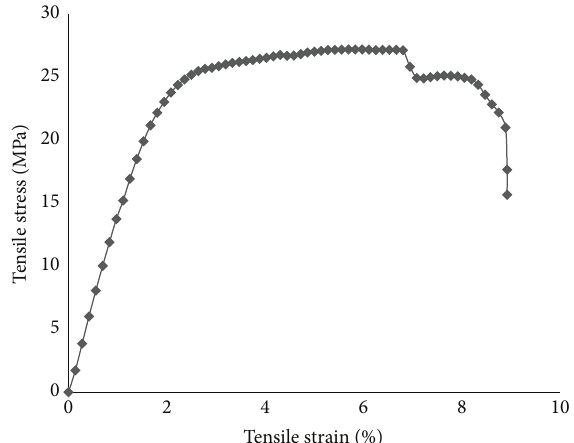
Figure 10: Stress-strain graph of Epoxy/kenaf/PET (60/20/20) hybrid composite.